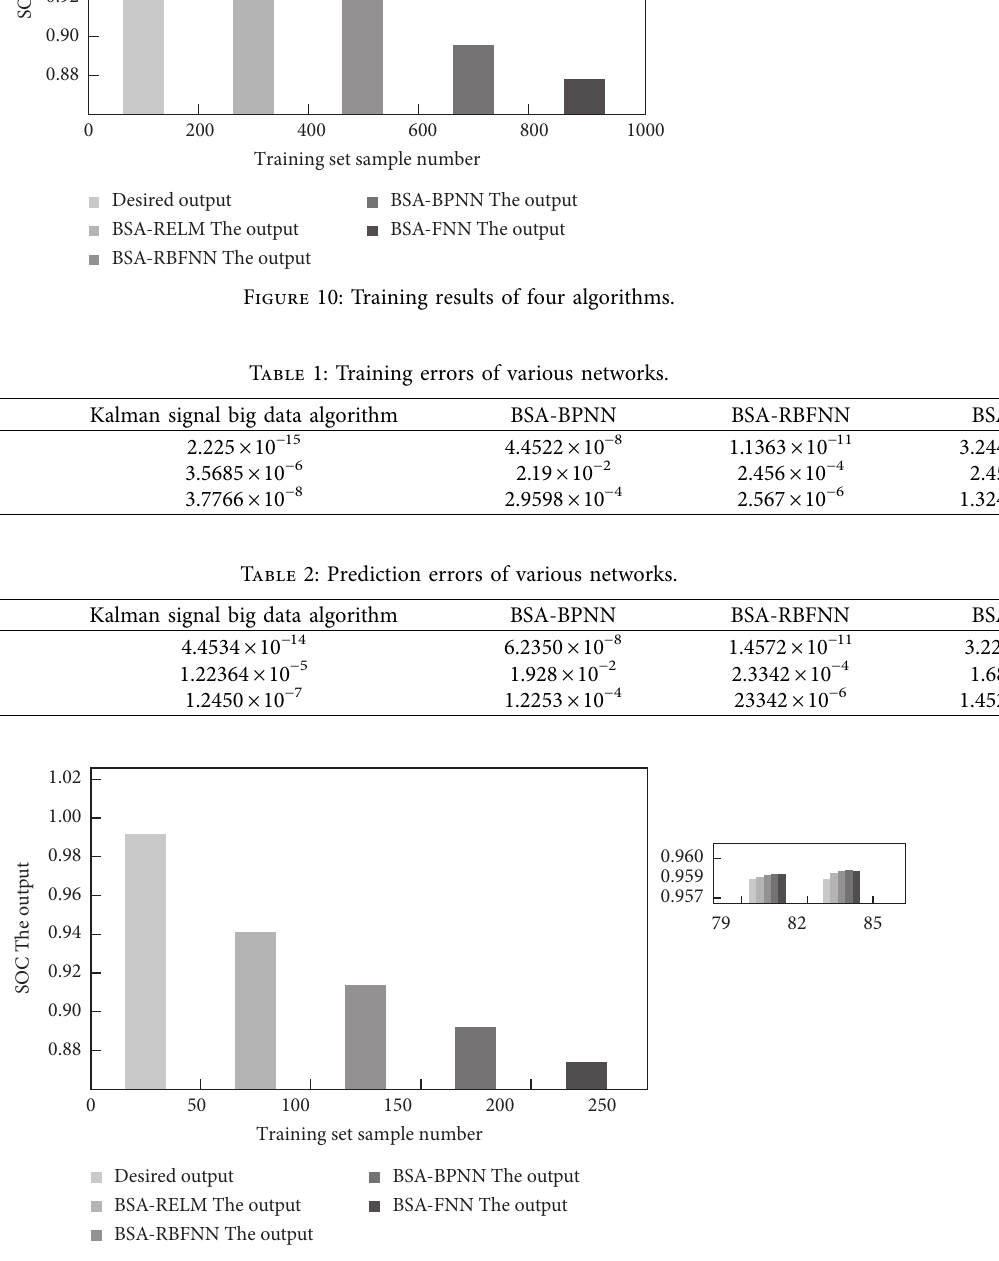
Figure 11: Prediction results of the four